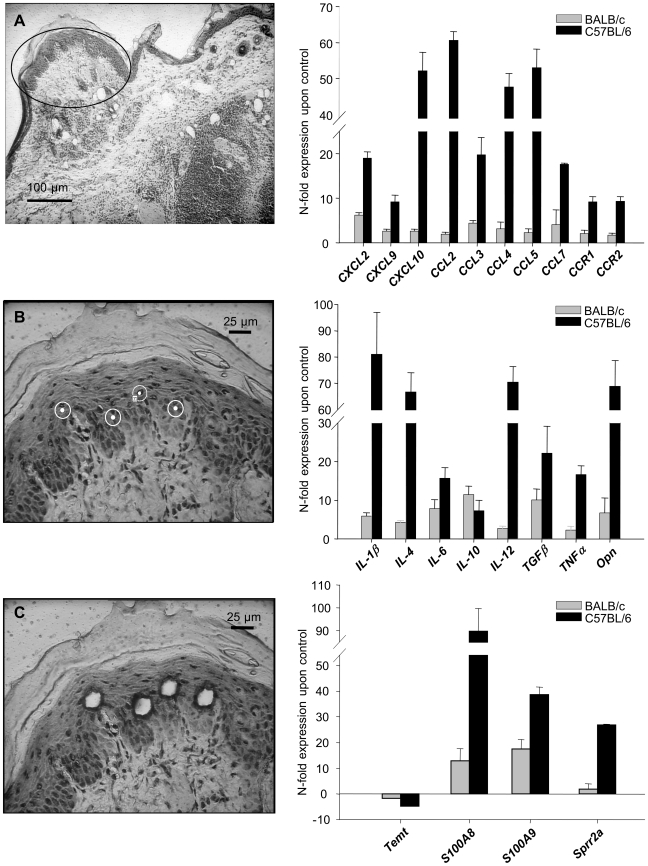
Analysis of gene in keratinocytes isolated from L. major infected skin.Laser capture microdissection (left panel). Single keratinocytes were dissected from cryosections of infected and control skin as described in Materials and methods. A) Overview, cryosection (BALB/c mice 16 h after infection). B,C) Single keratinocytes of the stratum spinosum were selected, laser microdissected and pressure catapulted. RT-PCR Analysis of gene expression in microdissected keratinocytes from 16h L. major infected skin (right panel). The PCR data were normalized to GAPDH expression and N-fold regulation and SEM in comparison to PBS injected controls was calculated (n = 2). Grey bars: Regulation in BALB/c mice; Black bars: Regulation in C57BL/6 mice.